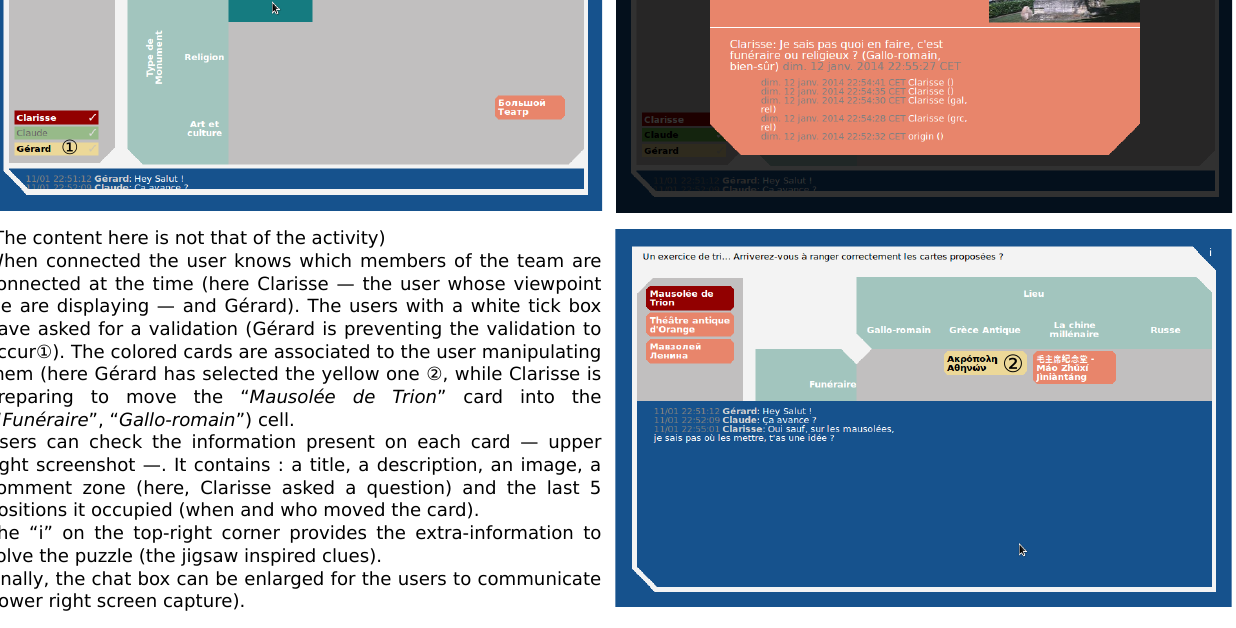
Figure 3. Screen capture and functionning of WESort Figure 3), add comments to each card (upper right image in Figure 3), chat with each other (lower